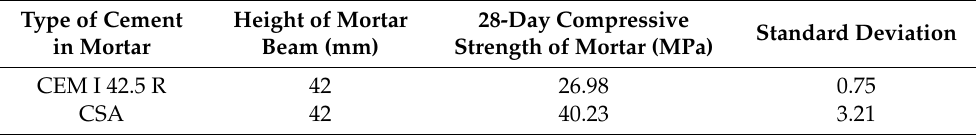
Table 5. Strength tests: MSWIBA accounts for 100% by weight of